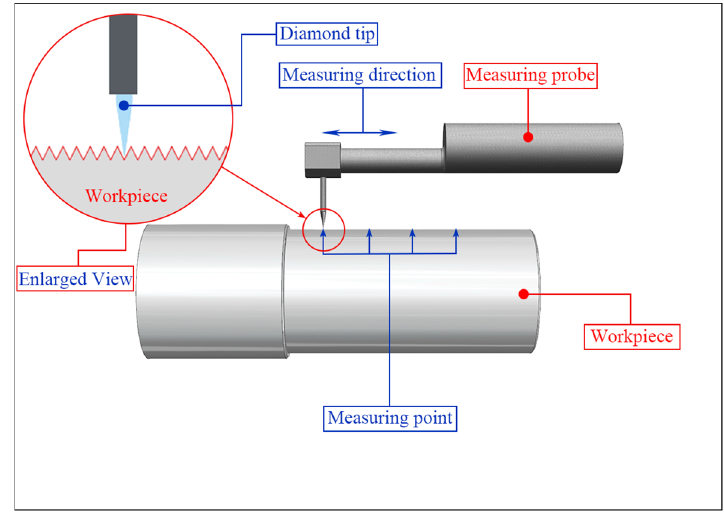
Figure 4. Schematic of surface roughness measurement at four points on a workpiece after cutting. Table 9. Specifications of the surface roughness measuring instrument used in the experiment.